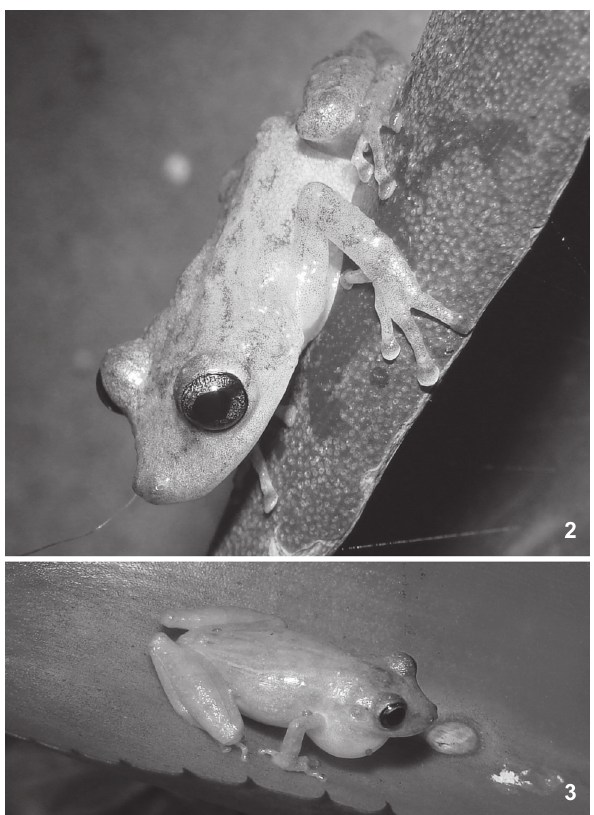
Figures 2-3. Living specimens of Scinax littoreus . Legend: (2) an adult male from Praia do Peró, Municipality of Cabo Frio, RJ (MNRJ 77231) and (3) an adult male from Pedra de Itacoatiara, Parque Estadual da Serra da Tiririca, Municipality of Niterói, RJ